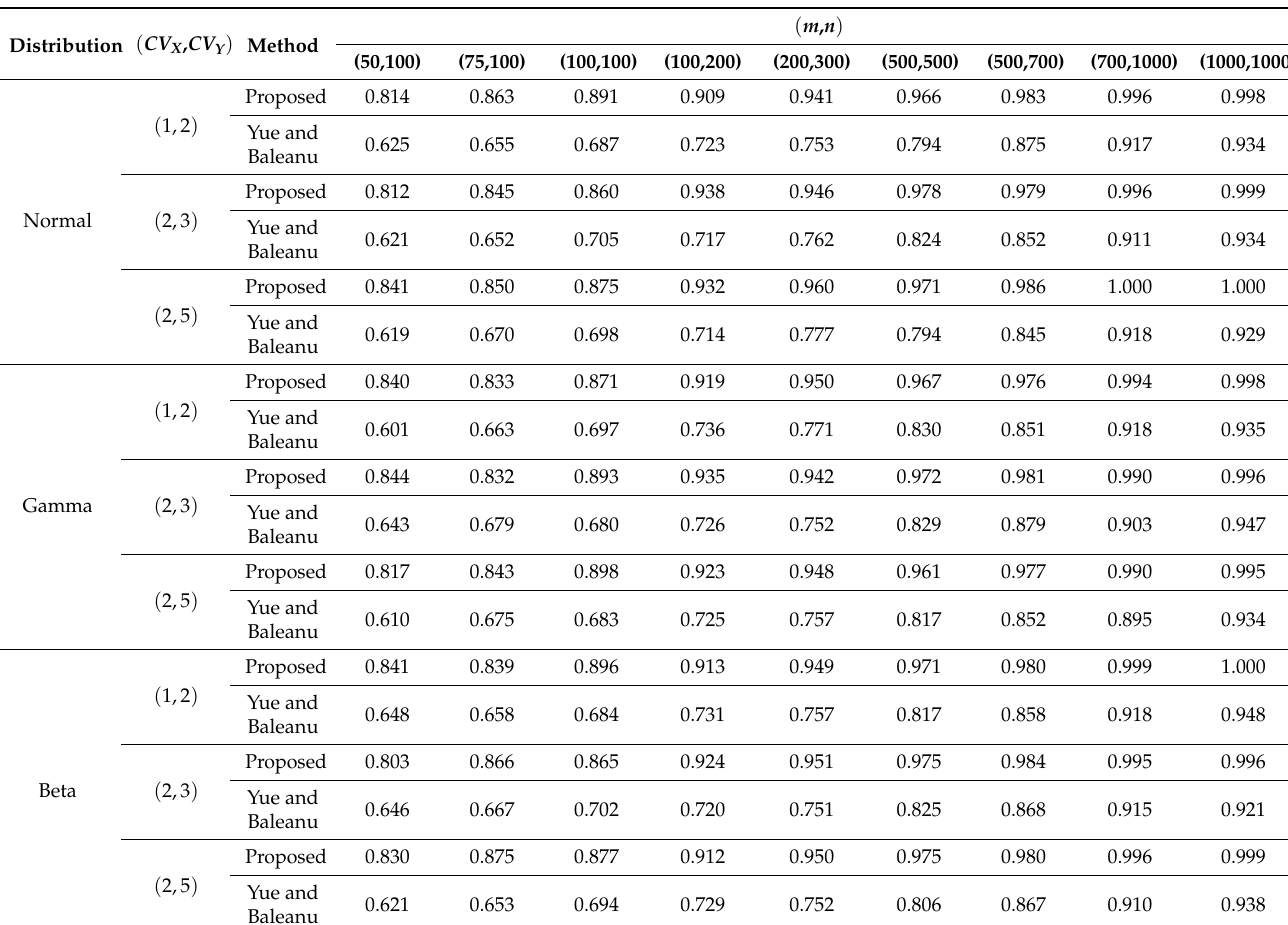
Table 5. The values of powers of the proposed and the Yue and Baleanu [27] methods, for various settings of